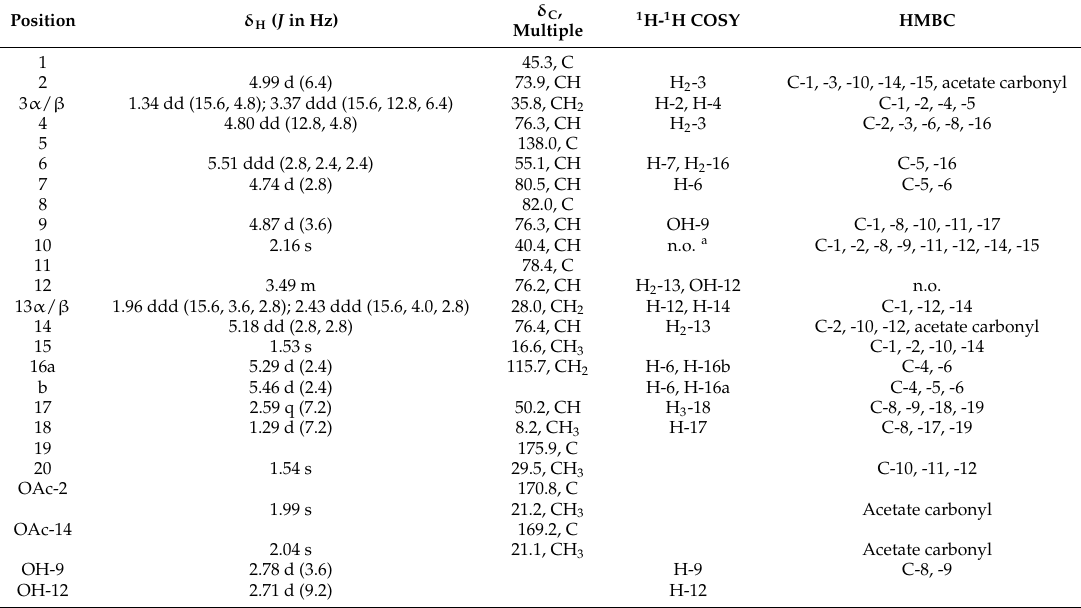
Table 3. 1 H (400 MHz, CDCl 3 ) and 13 C (100 MHz, CDCl 3 ) NMR data and 1 H– 1 H COSY and HMBC correlations for briarane 3 .